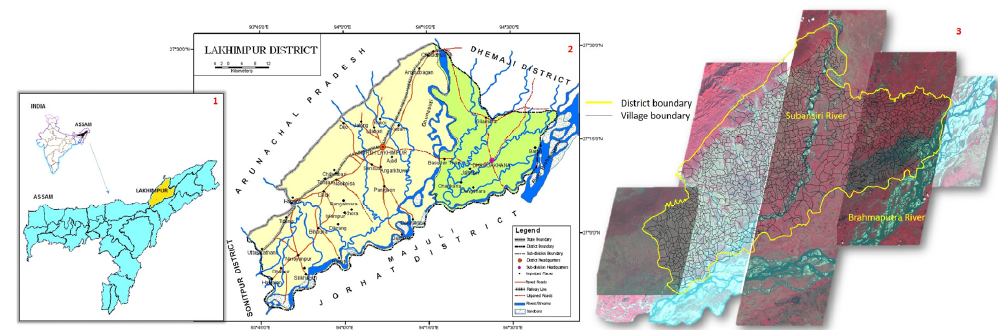
Figure 1. ( 1 ) Map of India and Assam state; ( 2 ) administrative map of Lakhimpur district; ( 3 ) mosaic of LISS imageries of study area. Total study area: 2277 km 2 , out of which 2257 km 2 is rural and 20 km 2 is urban.